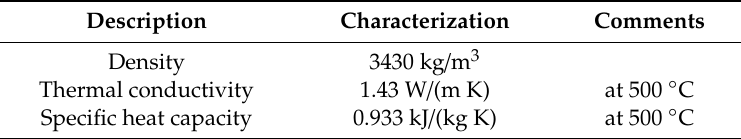
Table 3. Electric arc furnace (EAF) slag characteristics